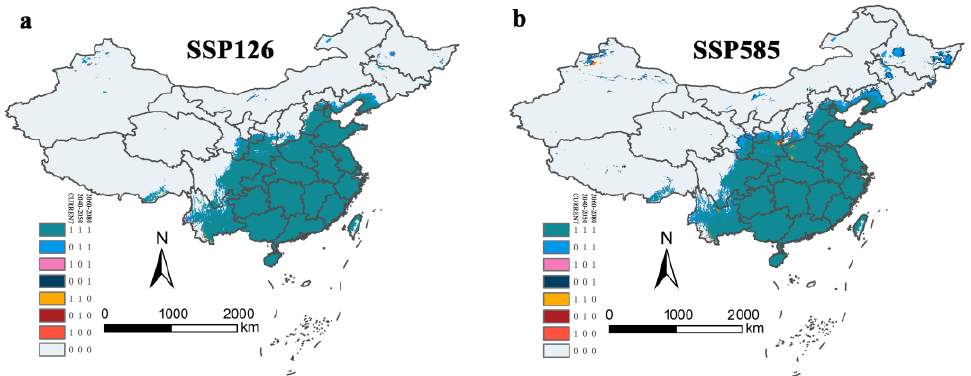
the three timespans (0,1,0) were 2208.117 km 2 (SSP 126) and 15,644.75 km 2 (SSP585), and areas (1, 0, Figure 10. Changes to suitable areas under the ( a ) SSP126 and ( b ) SSP585 scenario. Eight colors refer 1) were 249.004 km 2 (SSP126) and 46.98122 km 2 (SSP585) (Table 3). to eight situations that occurred in specific locations. Green (1, 1, 1) area refers to a relatively stable